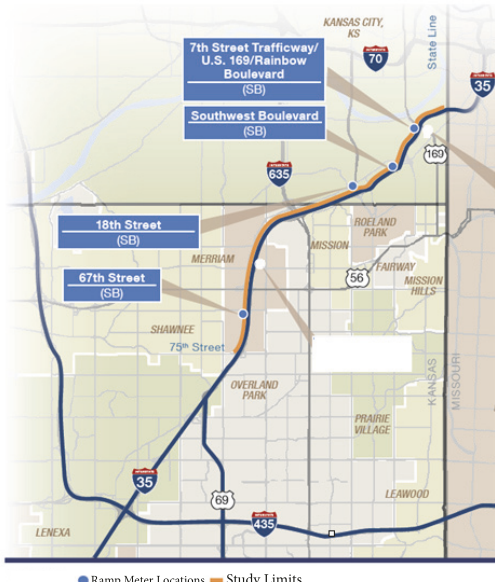
Figure 1: I-35 map and proposed metered junctions (provided by KDOT and KC